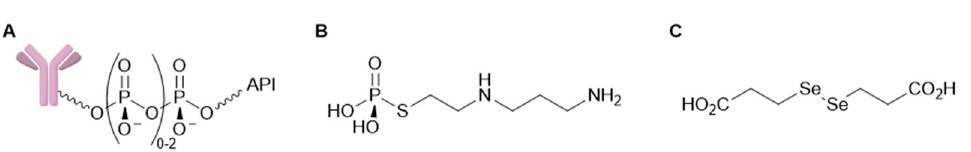
Figure 1. Anticancer agents including ionizable functions which improve solubility: ( A ) antibody- drug conjugates; ( B ) amifostine; ( C ) 3,3 ′ -diselenodipropionic acid.